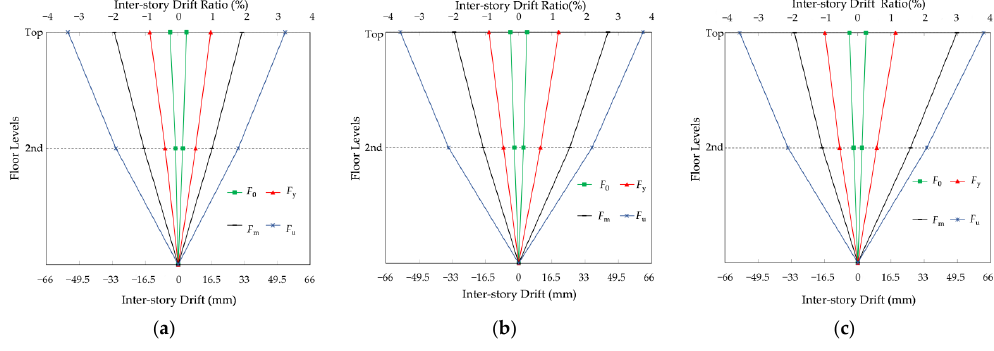
Figure 16. Distribution of interstory drifts and interstory drift ratios. ( a ) CS-1; ( b ) CS-2; ( c ) CS-3.